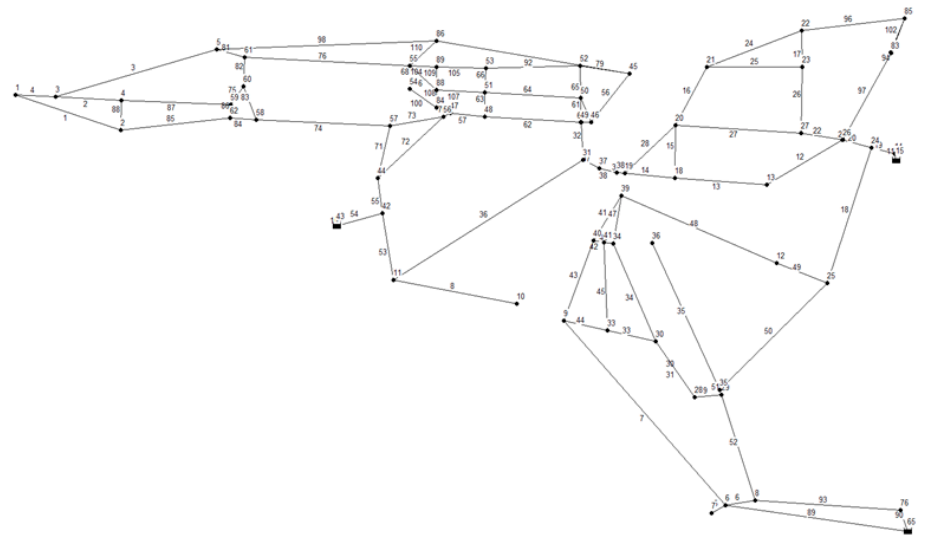
Figure 6. Layout of the Pescara network.